Question: Is the quantity shown trending increasing or decreasing?
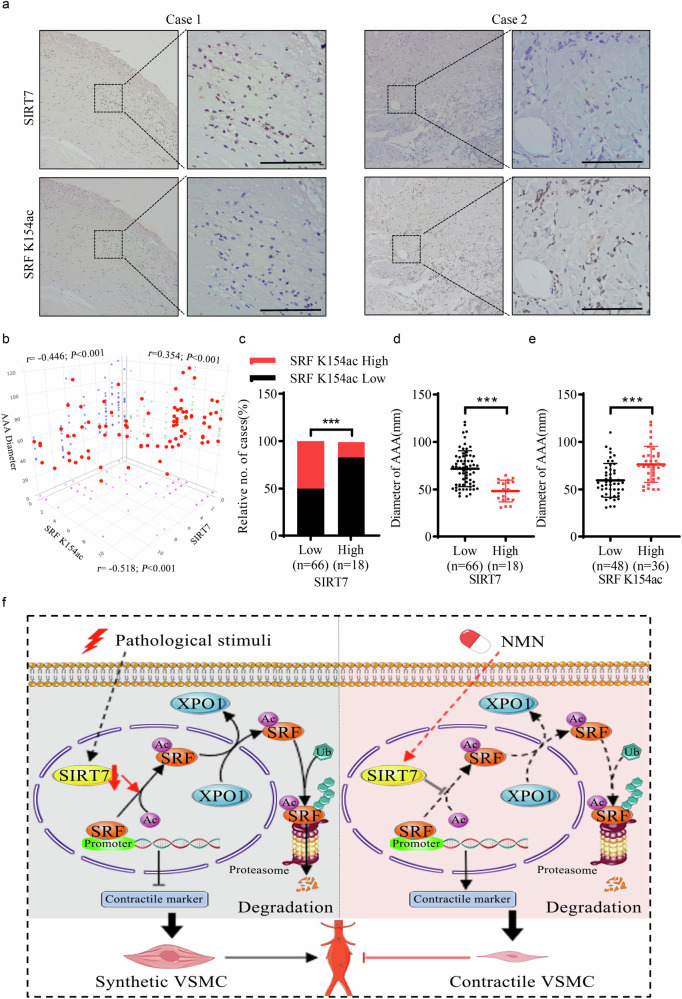
Answer: increasing